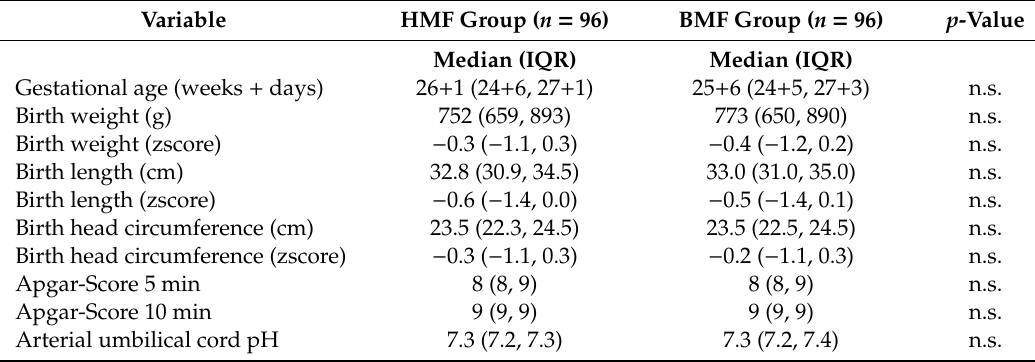
Table 2. Baseline characteristics of the study